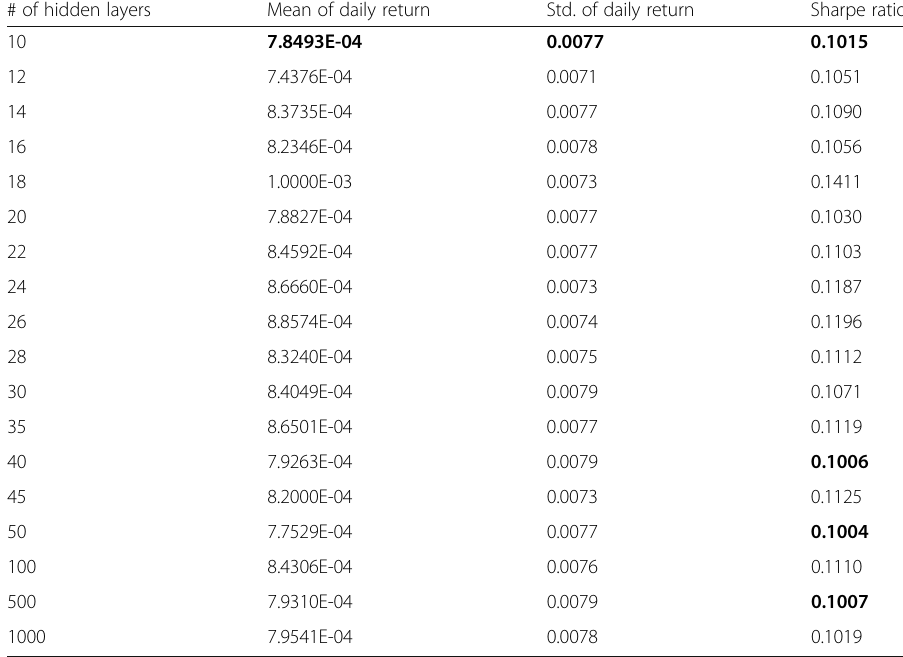
Table 6 Simulation results with ANN/DNN classifiers using entire untransformed data # of hidden layers Mean of daily return Std. of daily return Sharpe